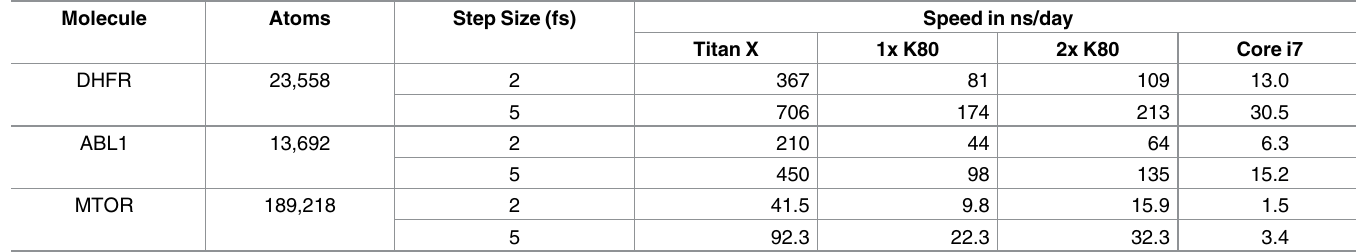
Table 2. Benchmark results for various protein systems in explicit solvent simulated with PME. Molecule Atoms